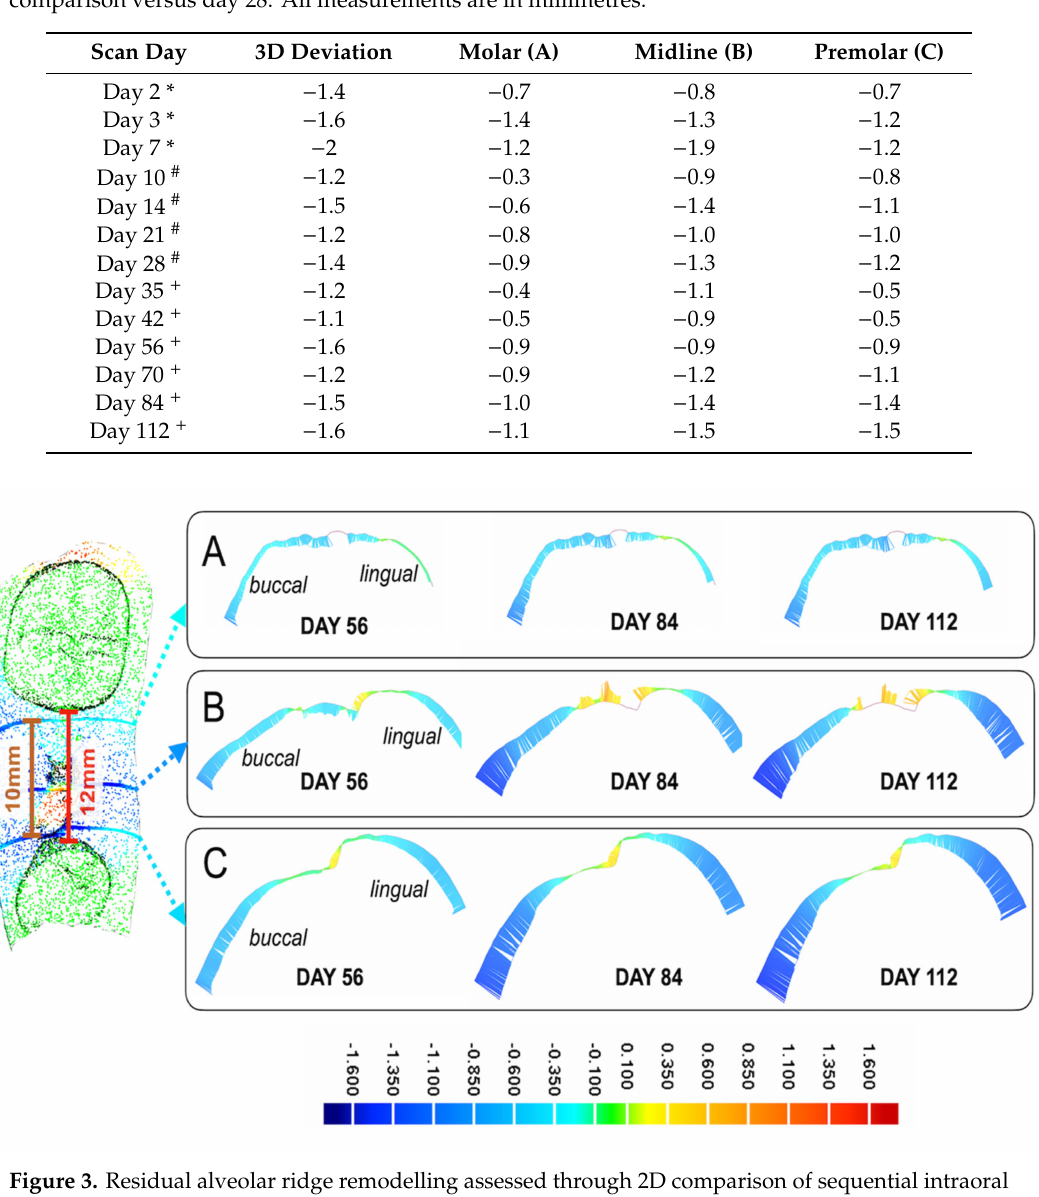
Table 1. Maximum deviation error calculated over 4 months using 3D and 2D deviation analyses (A,B,C). * Denotes comparison versus day 0 scan. # Denotes comparison versus day 7. + Denotes comparison versus day 28. All measurements are in millimetres.